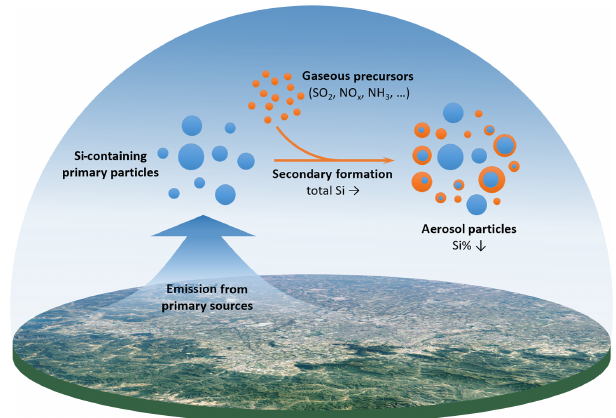
Figure 1. Scheme showing the role of Si during the secondary for- mation process of aerosol particles. Note: this scheme only reflects the role of Si but does not show all reactions involved in the sec- ondary aerosol